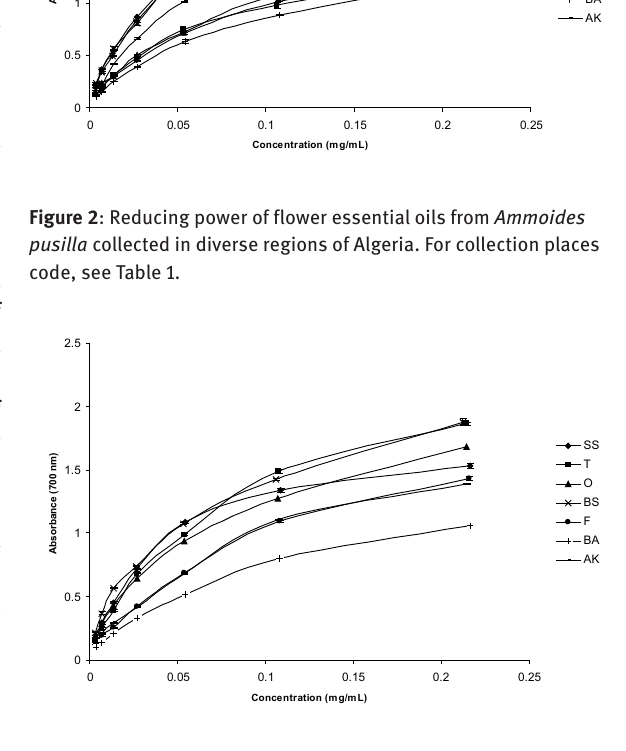
Figure 3 : Reducing power of leaf essential oils from Ammoides pusilla collected in diverse regions of Algeria. For collection places code, see Table